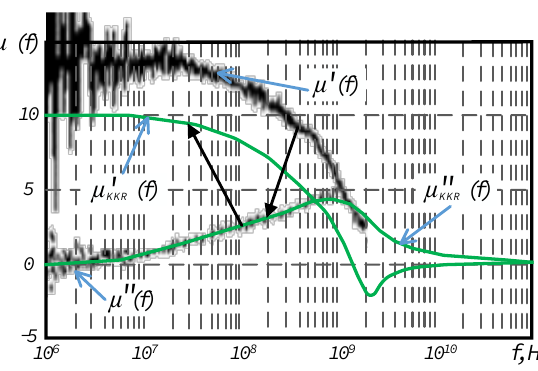
Fig. 5. KKR application to CIP spectrum of Fe 78 Si 13 B 9 . [5], Fig. 3, a.